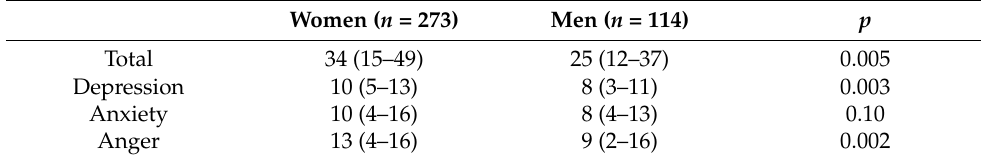
Table 1. Median and IQR scores for emotional eating subscales in women and men. Women ( n = 273) Men ( n = 114) p Total 34 (15–49) 25 (12–37) 0.005 Depression 10 (5–13) Anxiety p values for comparison of median scores between men and